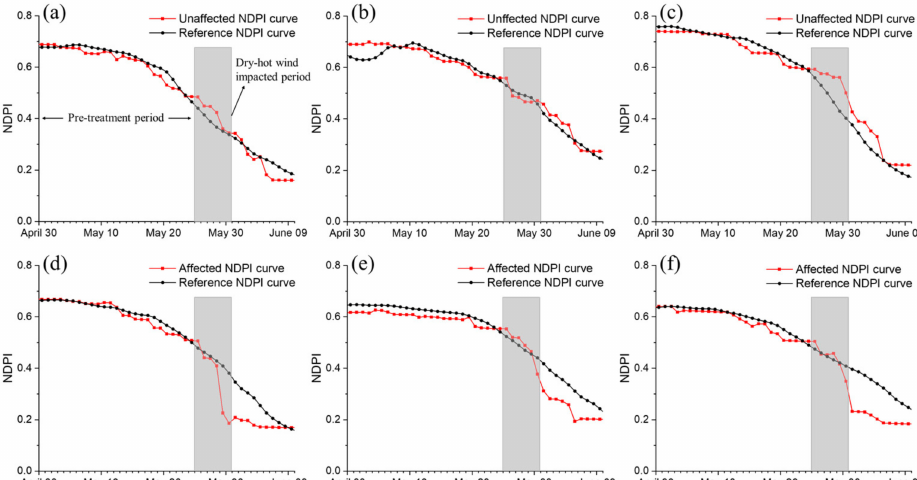
Figure 8. Visual inspection of the parallel trend assumption. The NDPI curves of three dry-hot wind years ( a , d ): 2007; ( b , e ): 2013; ( c , f ): 2014) are in red and their corresponding reference curves are in black. Typical pixels unaffected by dry-hot wind are shown as the first row ( a , b , c ) while typical pixels affected by dry-hot wind are shown as the second row ( d , e , f ). The dry-hot wind impacted periods are marked by a gray